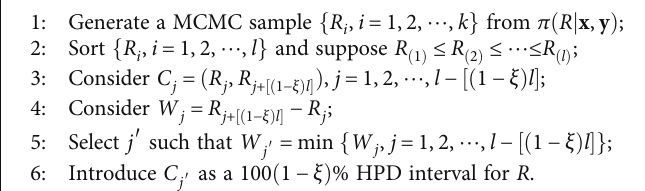
Algorithm 1: Chen-Shao algorithm for R